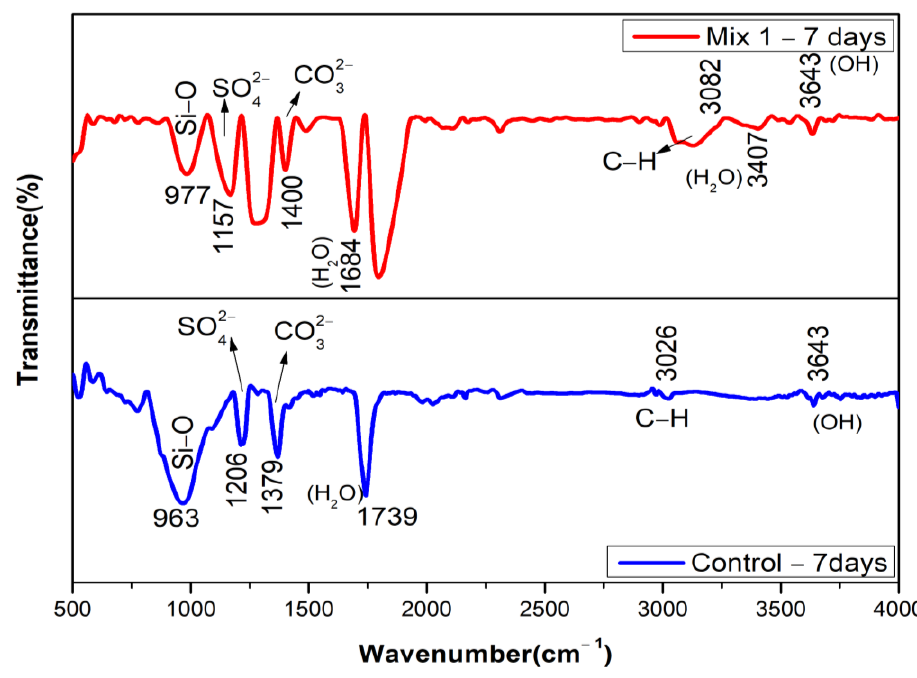
Figure 11. FTIR of 7-day hydrated samples (Mix 1 and Control).